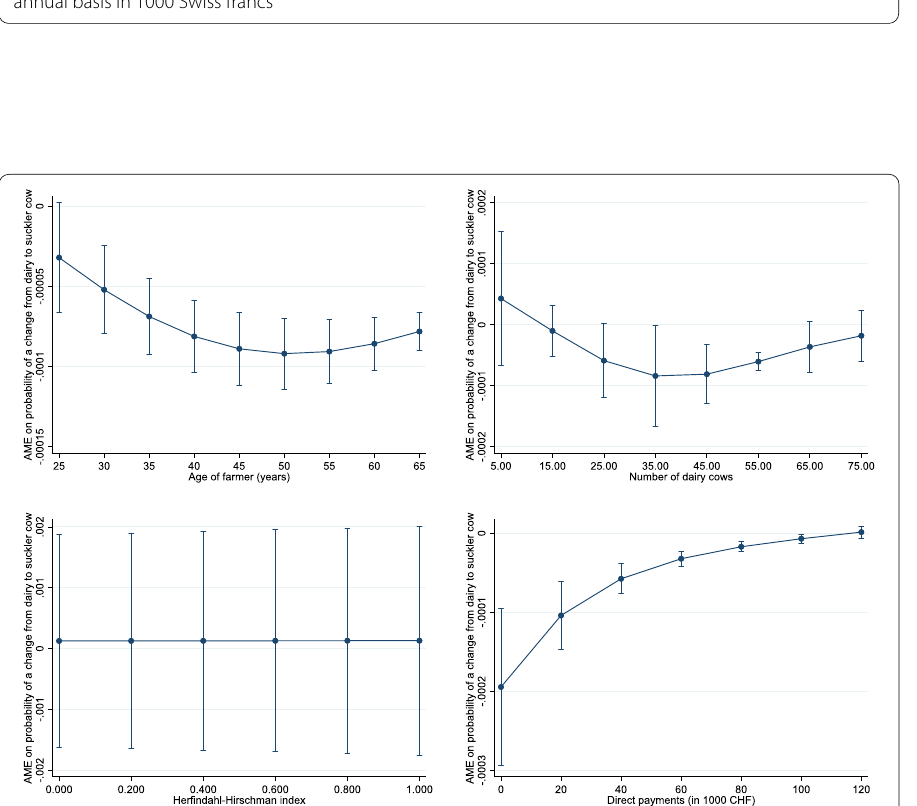
Fig. 5 Average marginal effect of logistic regression for the probability of a change from dairy to suckler cow. Notes : Point estimates (solid line) with 95% confidence interval (dashed lines). Direct payments are